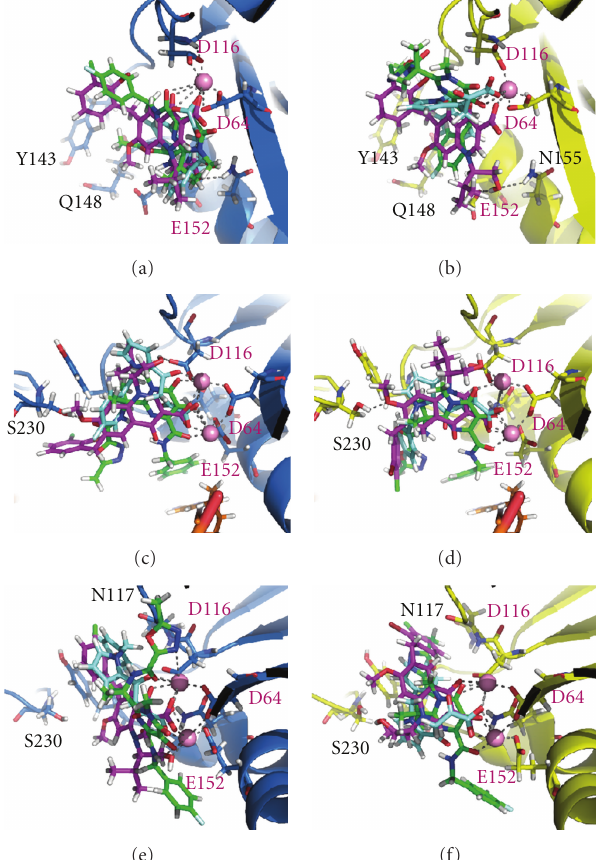
Figure 4: RAL (green), ELV (magenta), and L731,988 (cyan) best poses predicted by Glide. The inhibitors were docked into the active site of unbound IN (top) and IN · DNA complex (middle) and IN in holo conformation without DNA (bottom) from of the B (in blue) and CRF02 AG (in yellow). Proteins and DNA are shown as cartoons, inhibitors as sticks, and Mg +2 cations as